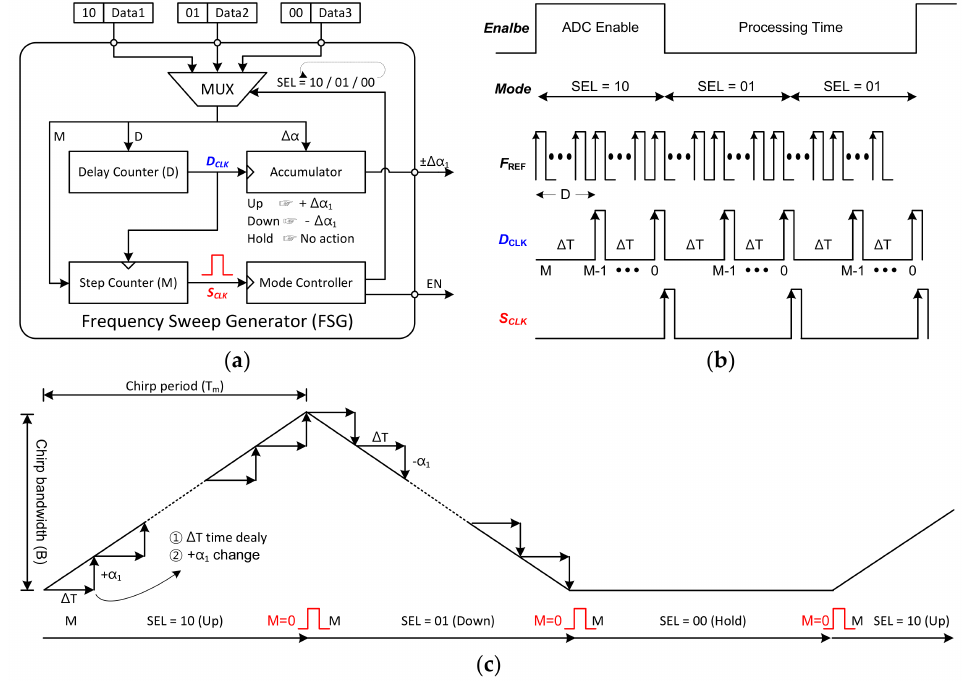
Figure 18. A general description of the frequency sweep generator (FSG). The detailed block diagram is shown in ( a ); The timing chart of the FSG is described in ( b ); Finally, on the time axis, the principle of how to generate FMCW waveform is expressed in ( c